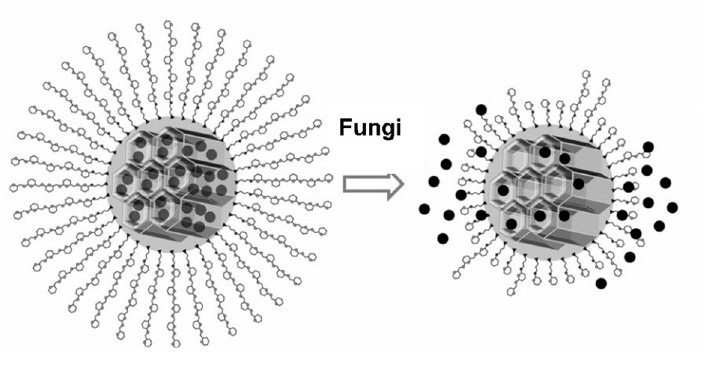
Figure 1. Representation of the Saccharide-MSN-Eu system in the presence of exogenous fungal enzymes.